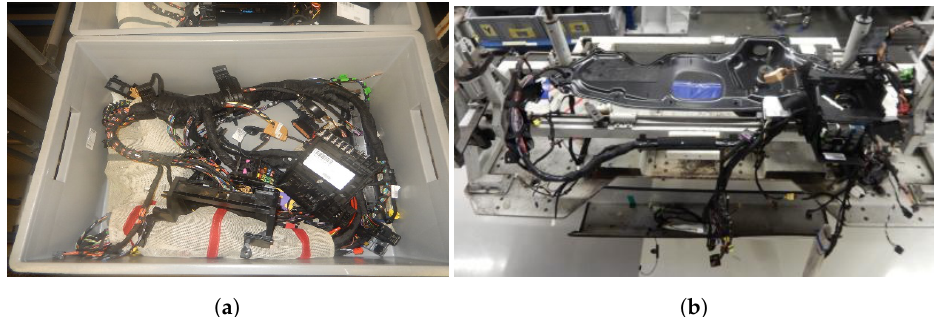
Figure 1. Wiring harness at the production line: ( a ) in the box, ( b ) at the mounting